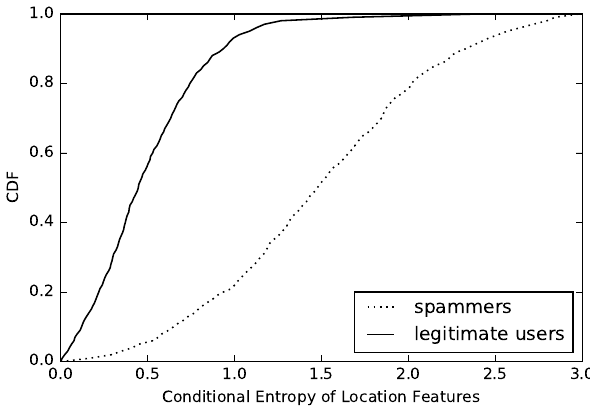
Figure 6. Conditional entropy of location-based